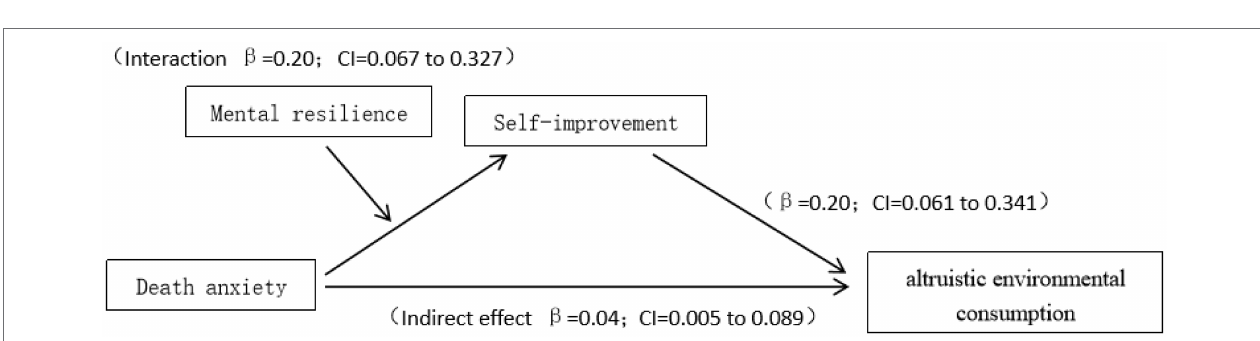
FIGURE 3 | Mediating effect analysis.